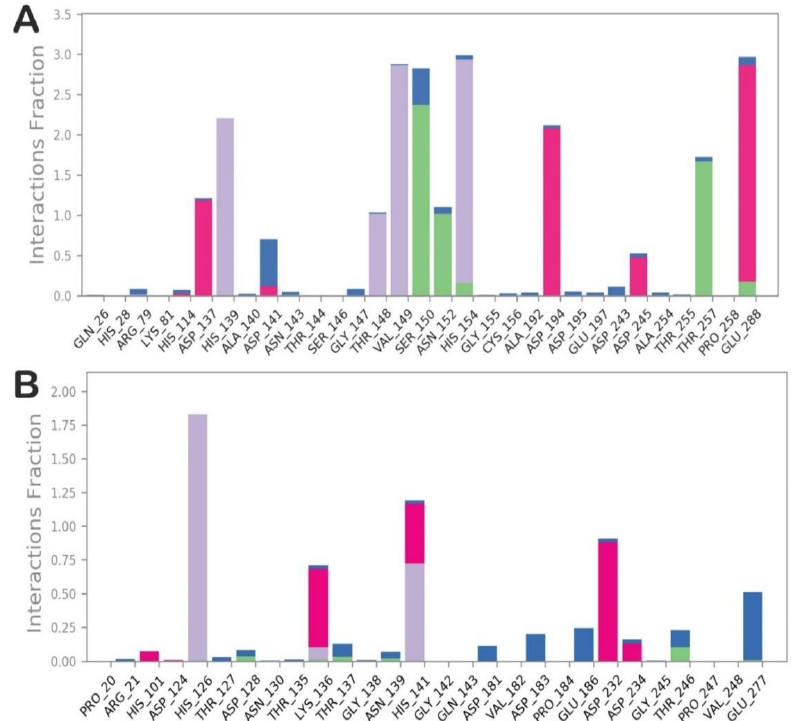
Figure 6. ( A ) Contacts established during the MD simulation by compound 14 within the binding site of L-ARG; ( B ) Contacts established during the MD simulation by compound 14 within the binding site of B-ARG. The pictures were generated by the MD tools analysis implemented in Desmond. Categorization of protein–ligand interactions into four types: H-bonds (green), hydrophobic (grey), ionic (magenta), and water bridges (blue).